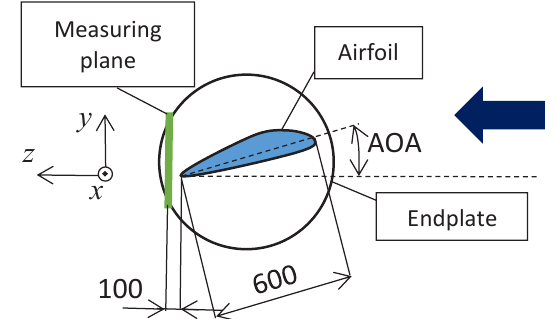
Fig. 1. Experimental setup schematics, side view .